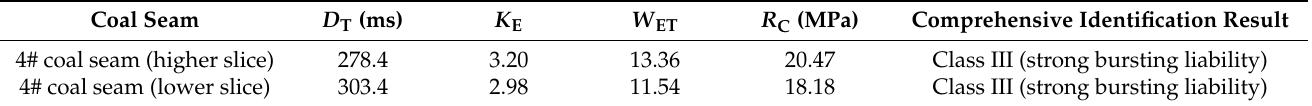
Table 2. Evaluation Results of Bursting Liability at 4# Coal